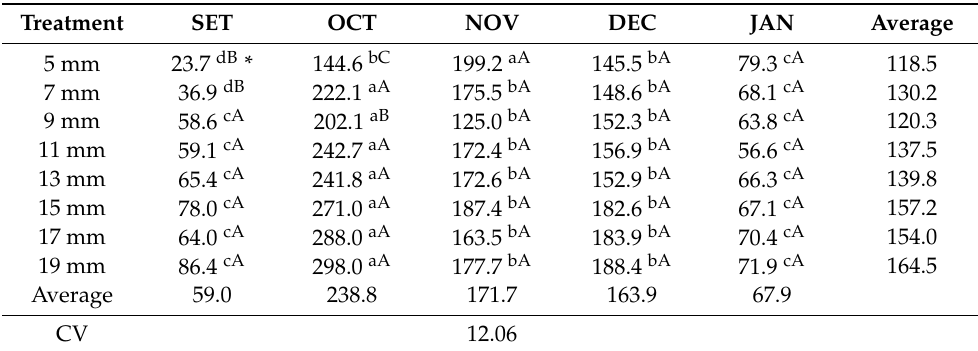
Table 3. Productive seasonality of strawberry plants cv. ‘Pircinque’, from plants with different crown diameters, in the agricultural cycle of